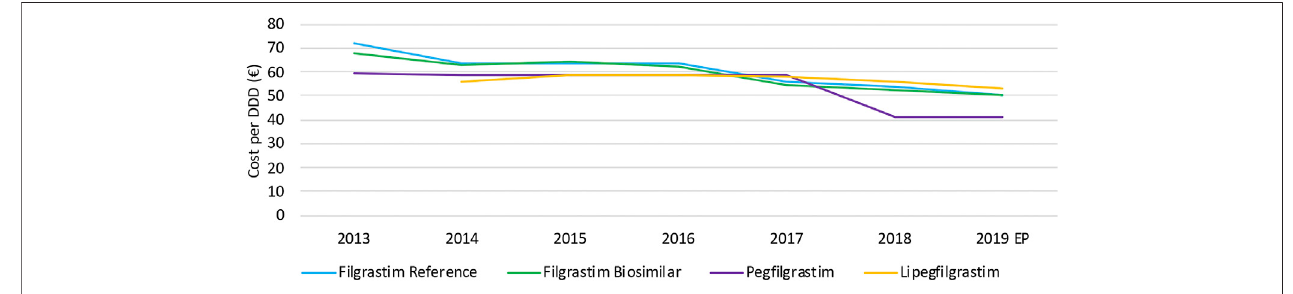
FIGURE 8 | Daily cost ( € per DDD) evolution of G-CSFs between 2013 and 2019. EP: Extrapolated